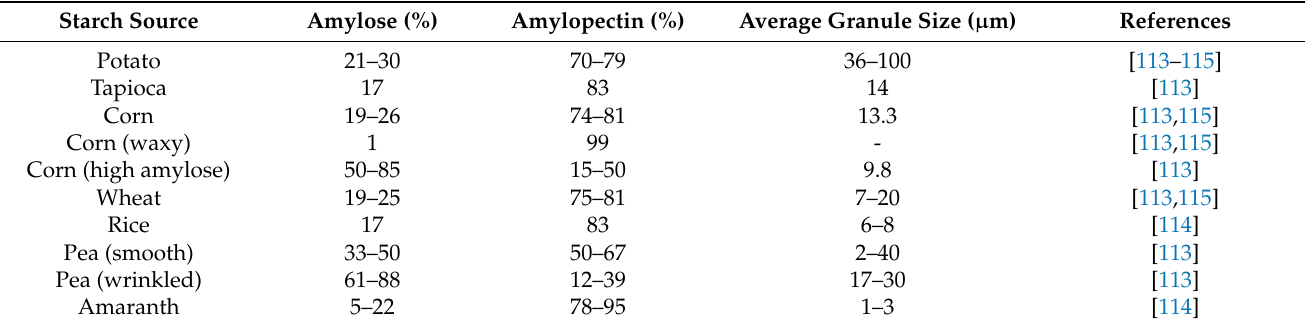
Table 3. Amylose and amylopectin content and granule size in various plant